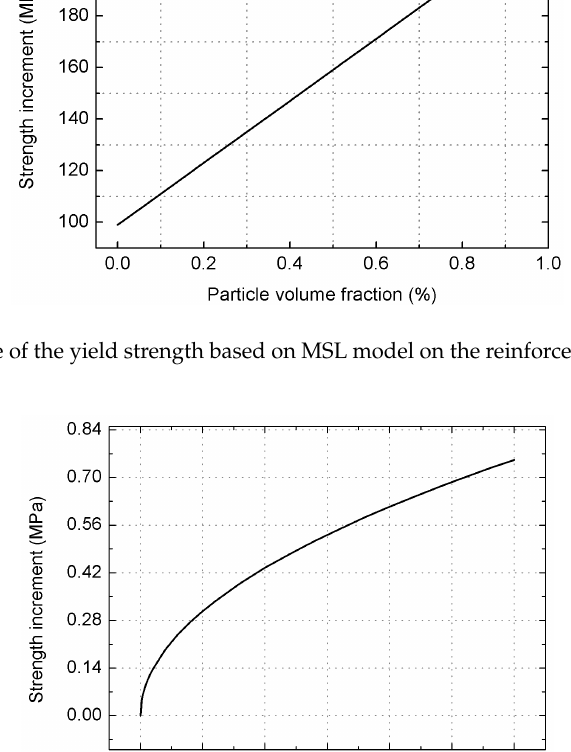
Figure 10. Dependence of the yield strength due to Orowan strengthening on the reinforcement volume fraction. volume